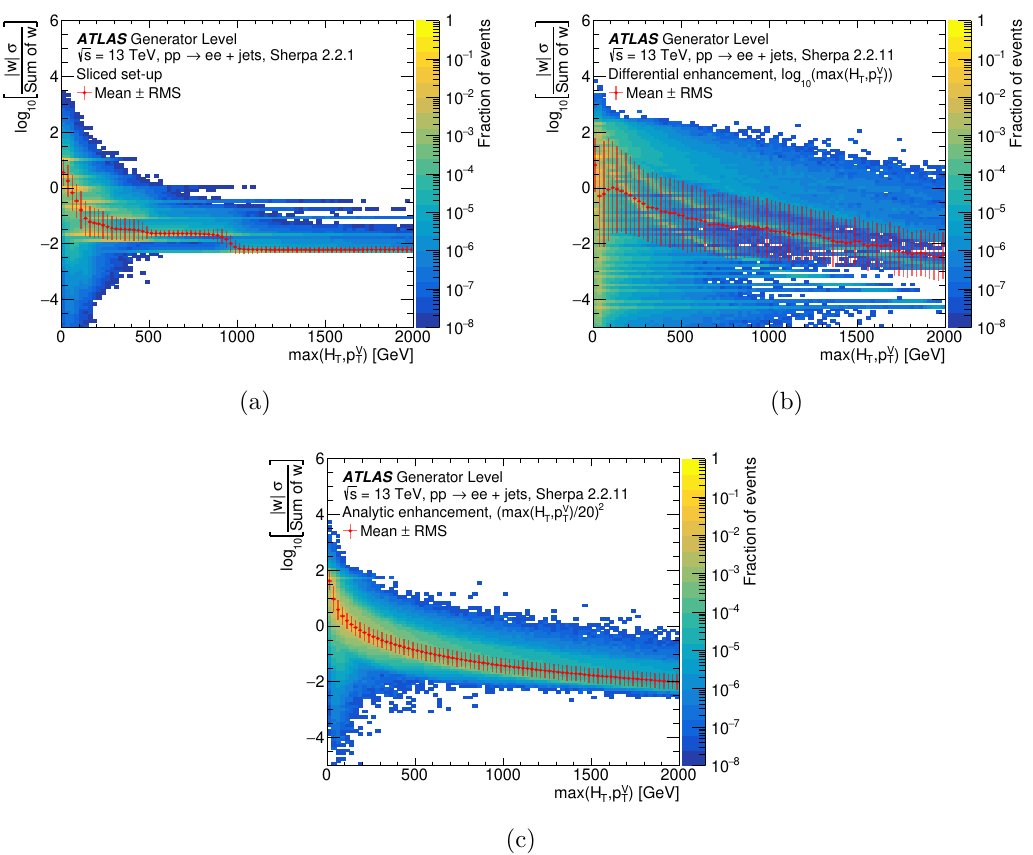
Figure 12 . Distributions of the logarithm of the absolute value of the event weight (w) times cross section ( σ ) divided by the sum of event weights as a function of max( H differential enhancement and (c) analytic enhancement Sherpa configurations. The distributions are normalized to